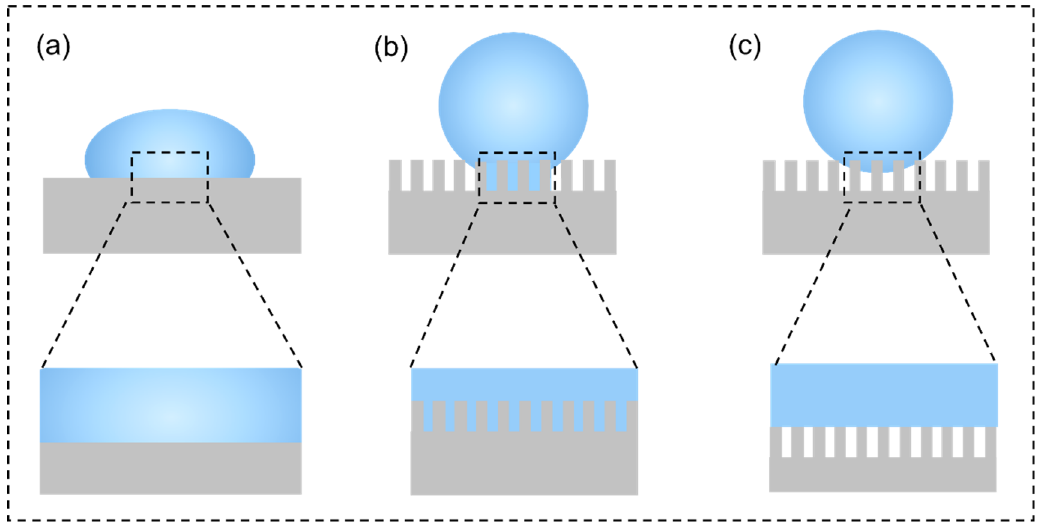
Figure 4. Three theoretical models: ( a ) Young model ( b ) Wenzel model, ( c ) Cassie–Baxter model.